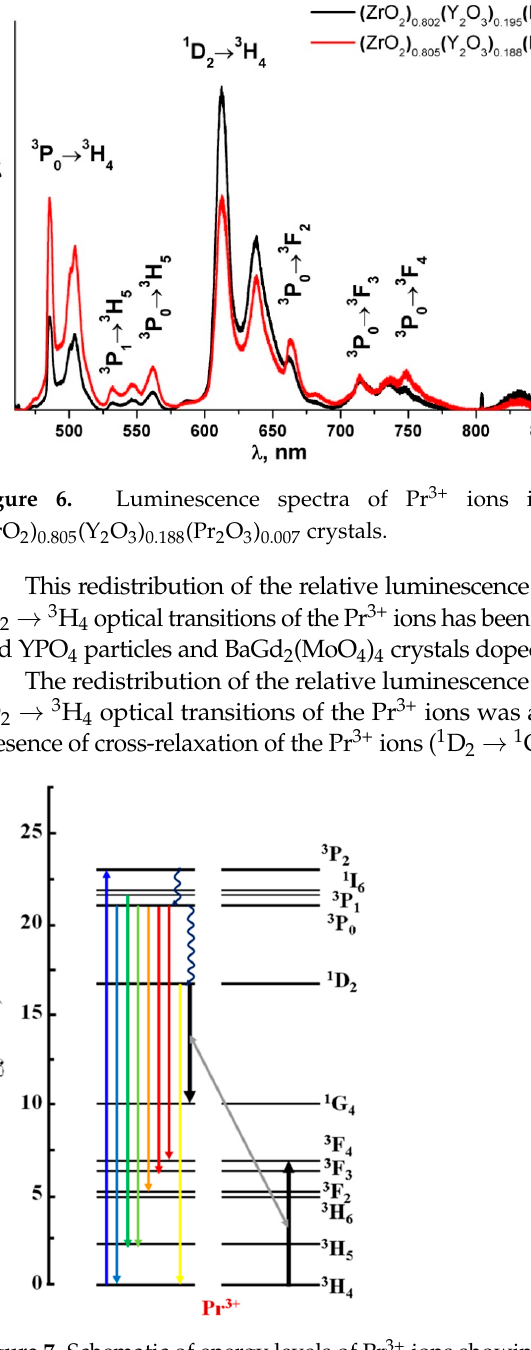
Figure 7. Schematic of energy levels of Pr 3+ ions showing the cross-relaxation process ( 1 D 2 → 1 G 4 ) → ( 3 H 4 → 3 F 4 ) for these ions (black arrows). The arrow color determines the corresponding spectral range of optical transitions.